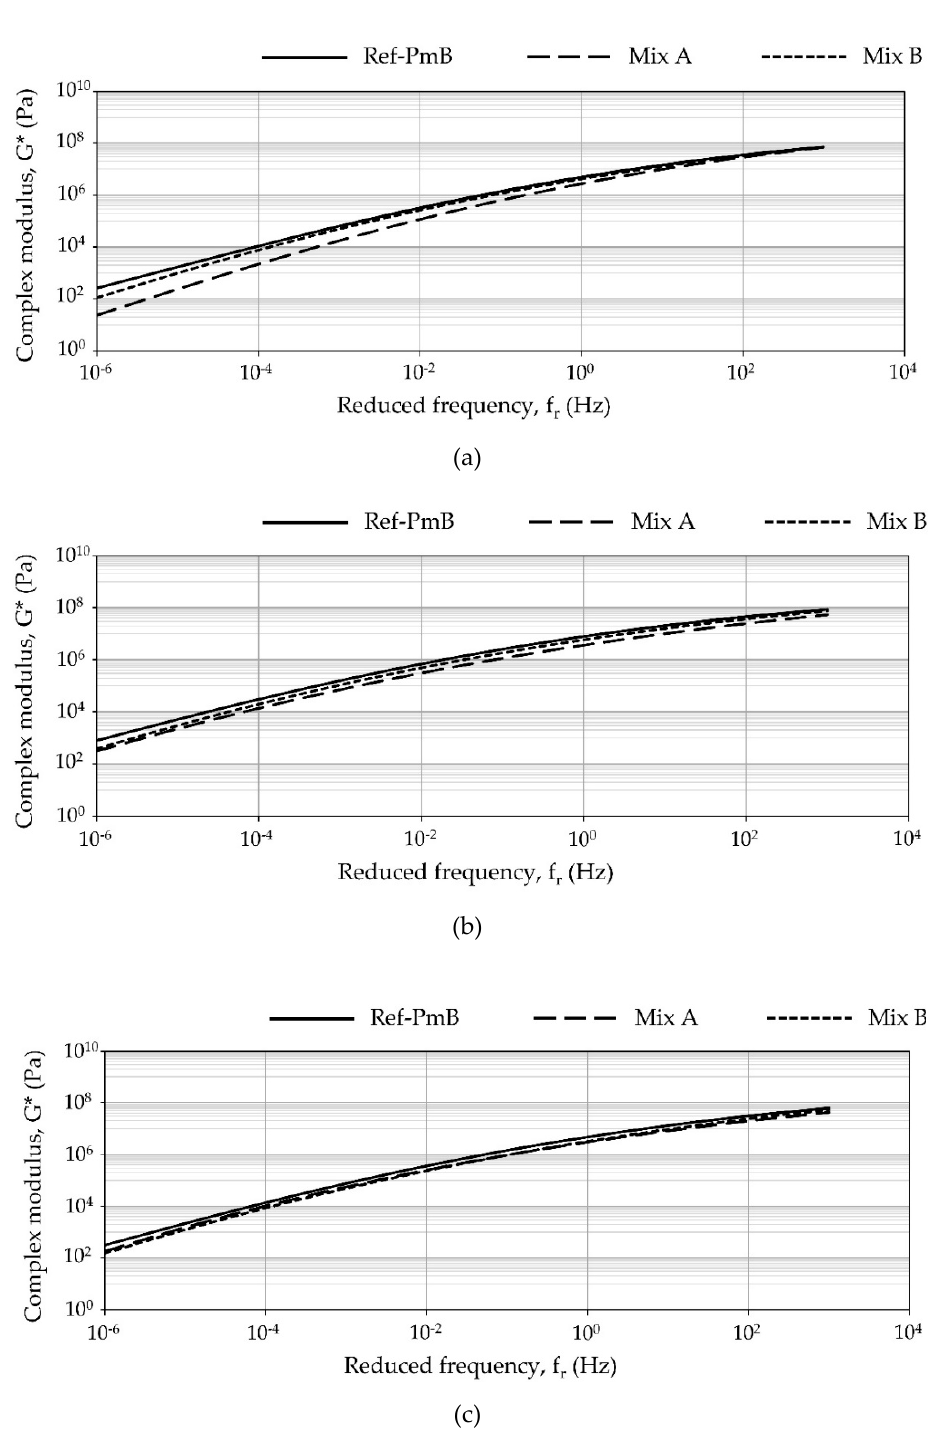
Figure 7. Complex shear modulus (G*) values of the recovered binder from the ( a ) original mixtures, ( b ) aged mixtures, and ( c ) recycled ( b ) aged mixtures, and ( c ) recycled mixtures.